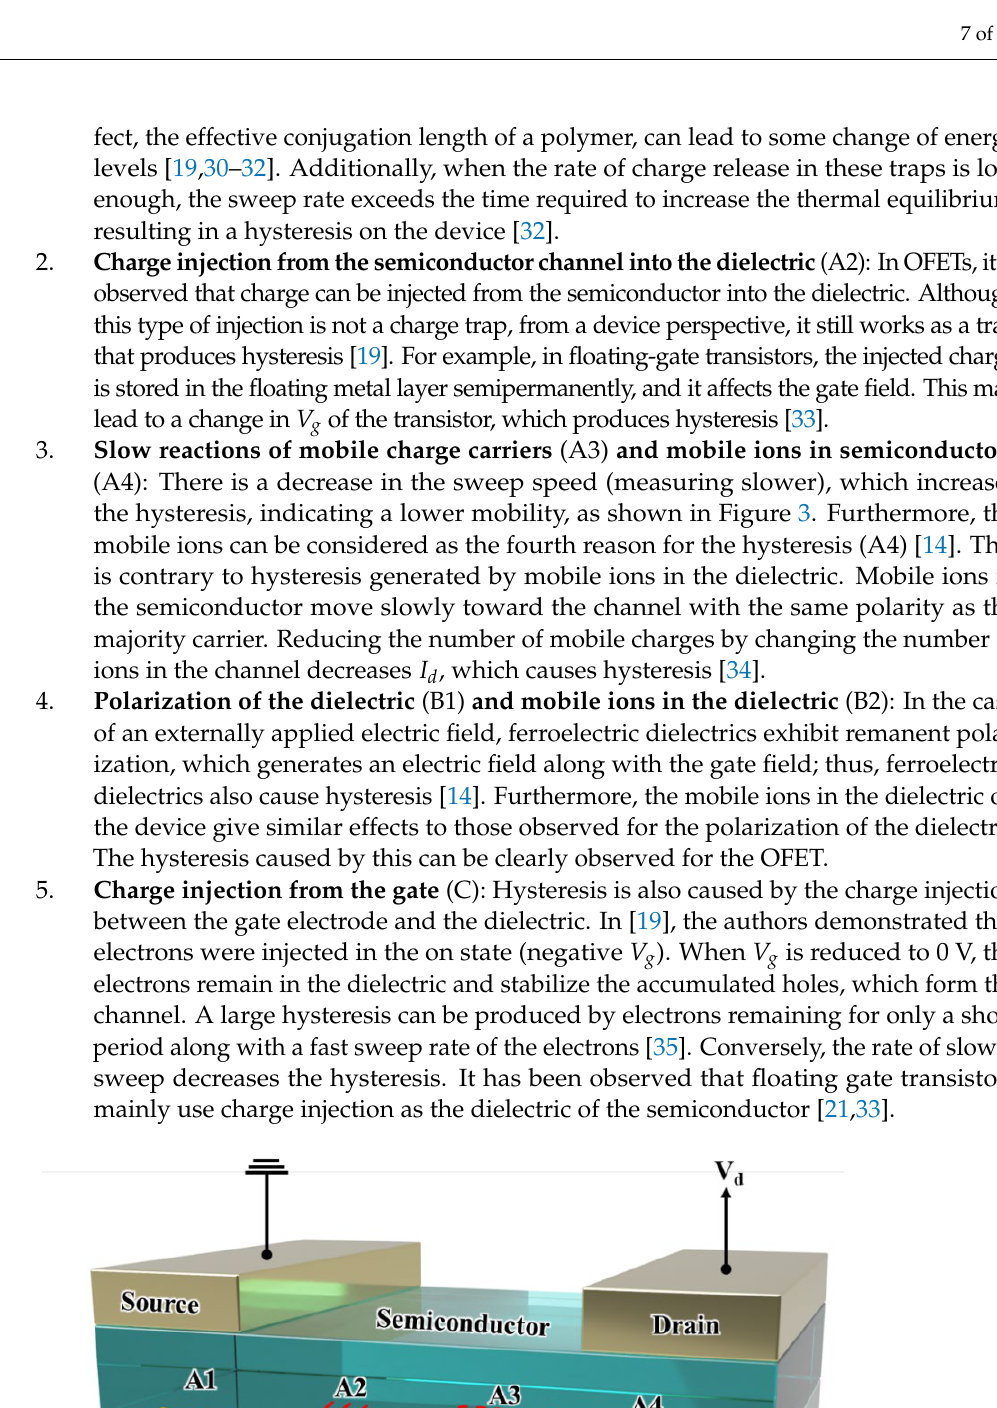
Table 1. Three typical hysteresis mechanisms and their sources [19]. Mechanisms